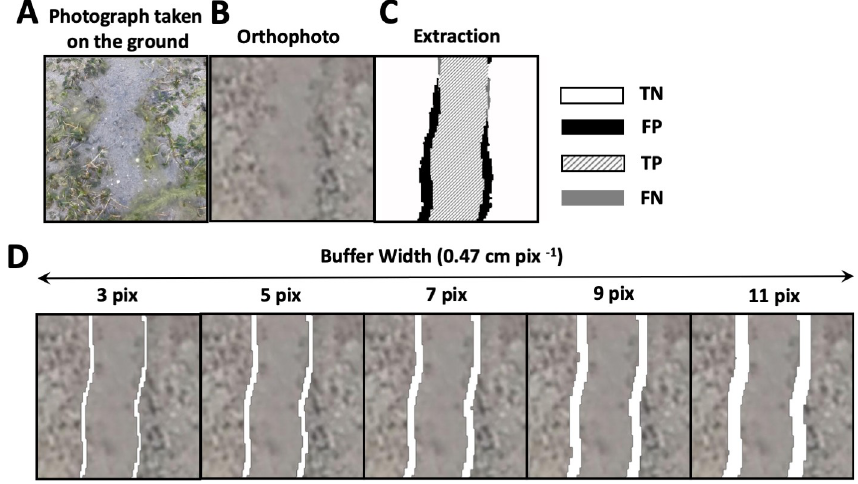
Fig 6. Reference diagrams for the buffer widths. (A) an example image of typical feeding trails taken during ground- based observations; (B) an example of the feeding trails on an orthophoto; (C) an example of the extracted feeding trails; and (D) the buffers for different widths. The white area in (D) shows the buffer.